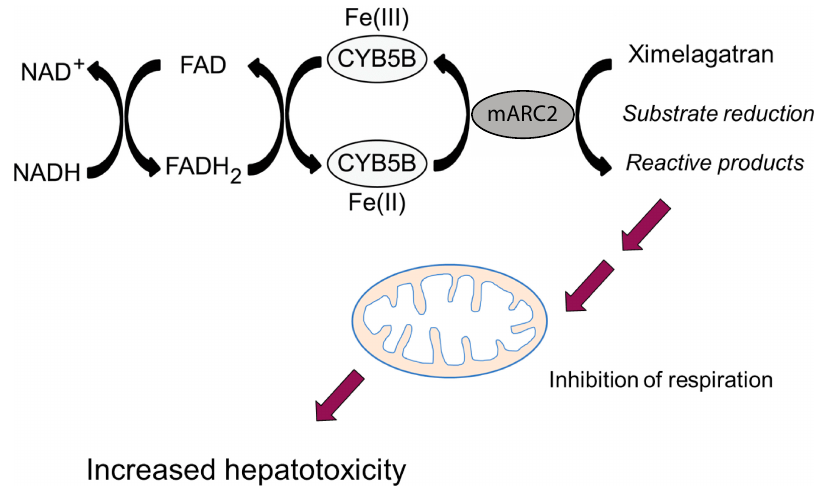
Figure 3. Proposed mechanisms of metabolic activation of ximelagatran. mARC2 in the outer mitochondrial membrane reduces ximelagatran to a reactive metabolite, which in turn inhibits mitochondrial respiration and causes hepatotoxicity.